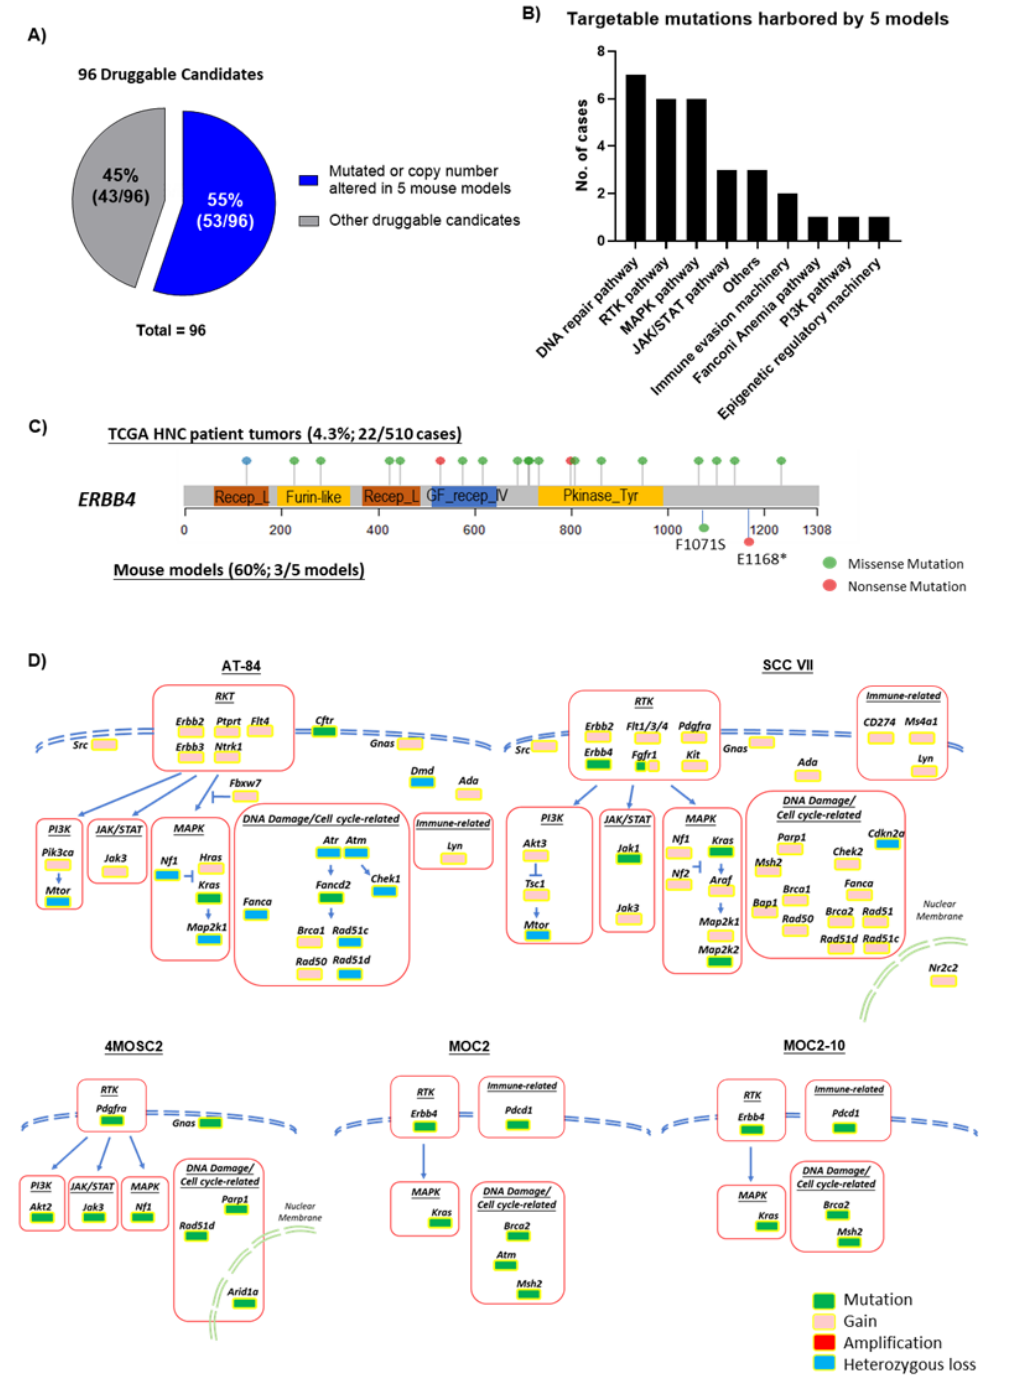
Figure 6. Potential druggability of genetic events represented by 5 mouse models vs. HNC patient tumors ( N = 510). ( A ) Pie chart showing 55% (53 / 96 genes) of druggable candidates are mutated or copy number altered in 5 mouse models. ( B ) Pie chart showing 13% of druggable events harbored by 5 metastatic mouse models are genes in the RTK signaling, followed by DNA repair pathway, other unclassified mutations, MAPK pathway, FA pathway, PI3K pathway, immune evasion machinery, JAK / STAT pathway, epigenetic regulatory machinery, and Notch pathway. ( C ) Mapping of mutation sites of ERBB4 represented by HNC patient tumors (upper) and the 5 mouse models in the tyrosine kinase domain (lower). ( D ) Summary mapping of aberrations of druggable candidates in 5 mouse models based on the RTK, MAPK, PI3K, NOTCH, JAK / STAT, and DNA damage / cell cycle-related pathways.